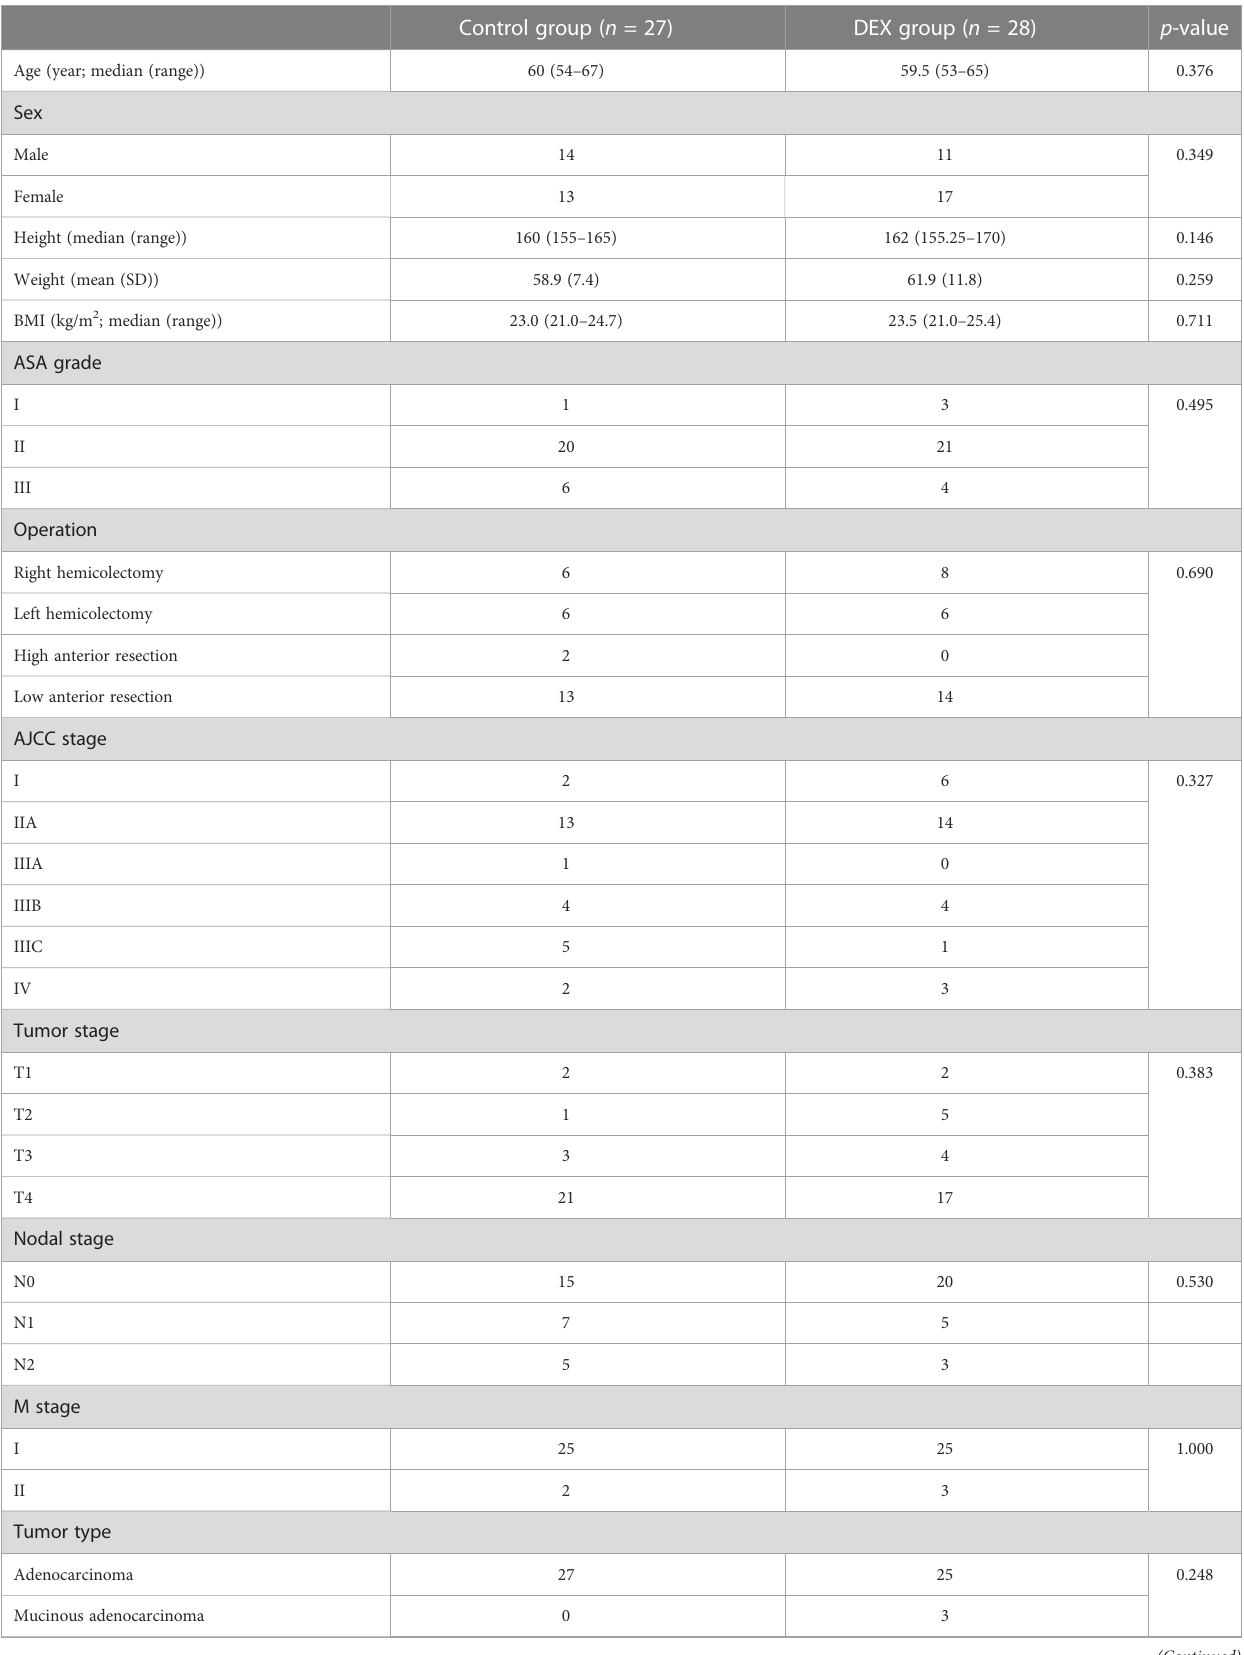
TABLE 2 Subject